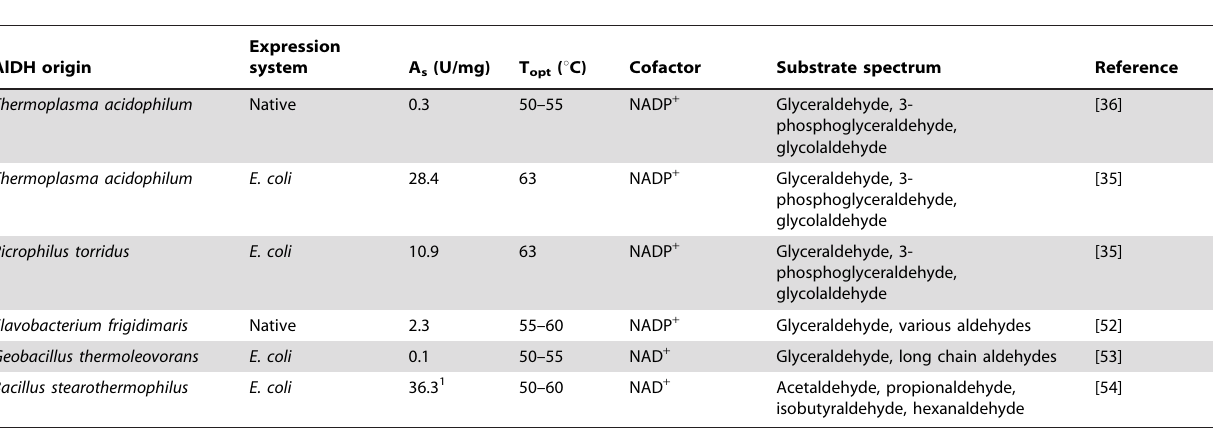
Table 1. Characteristics of thermostable AlDHs for the reaction cascade shown in Figure